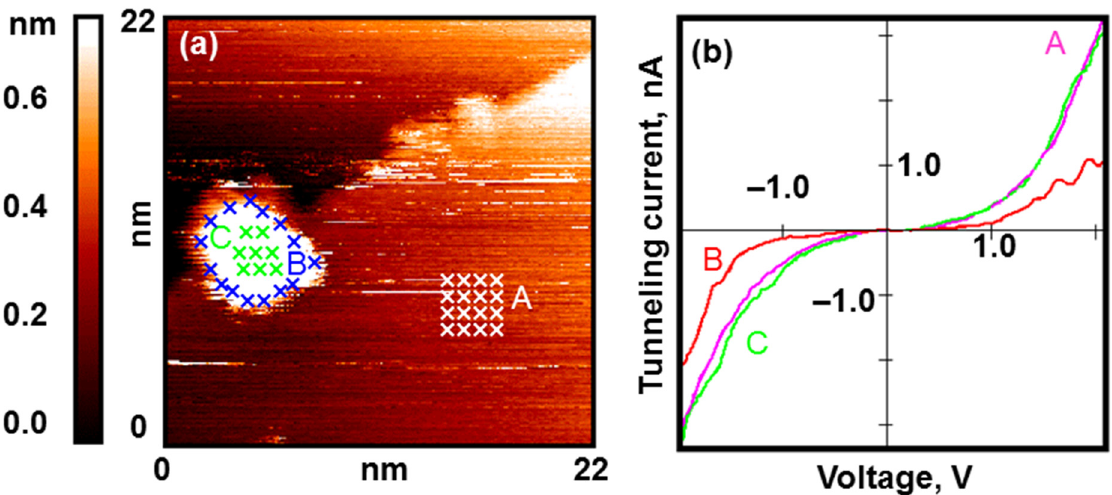
Figure 2. Gold nanoparticles after exposure to H 2 (50 L). Results of the STM/STS measurement: ( a ) topography image of the HOPG surface with deposited gold nanoparticles with the points of the spectroscopy measurements marked with crosses; ( b ) VAC curves of the tunneling currents averaged over the set of points on the surface of the HOPG (pink curve A), central (green curve C), and peripheral (red curve B) areas of the nanoparticle marked in ( a ).